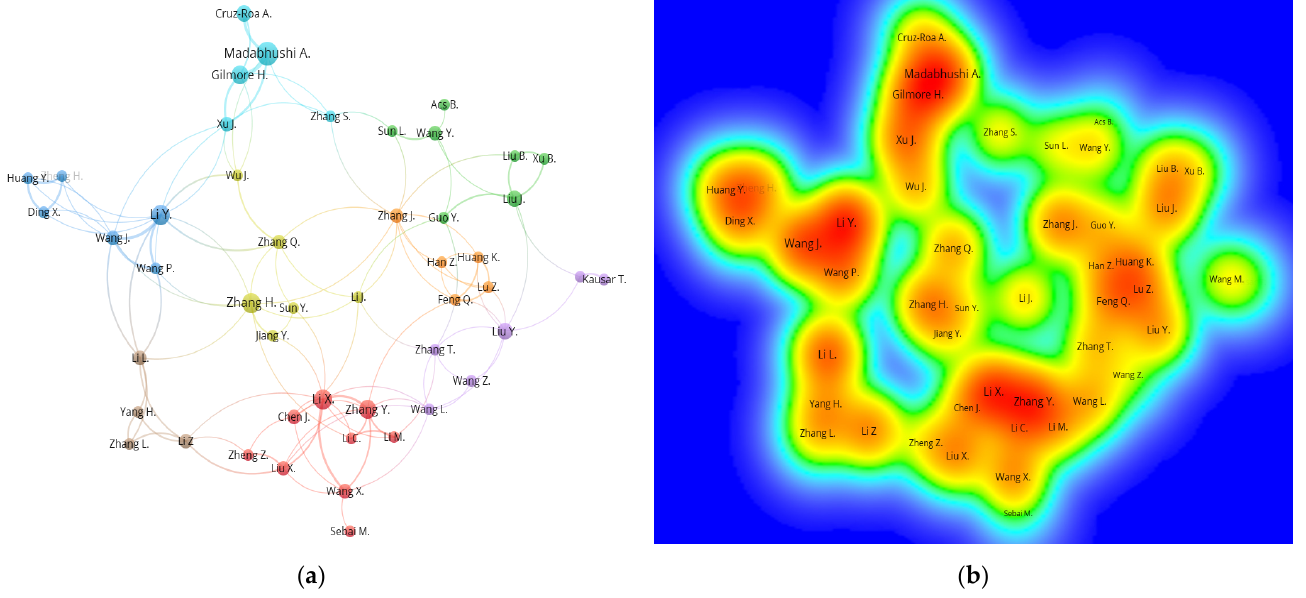
Figure 5. ( a ) Co-authorship network visualization of authors in publication for 2014–2021. ( b )